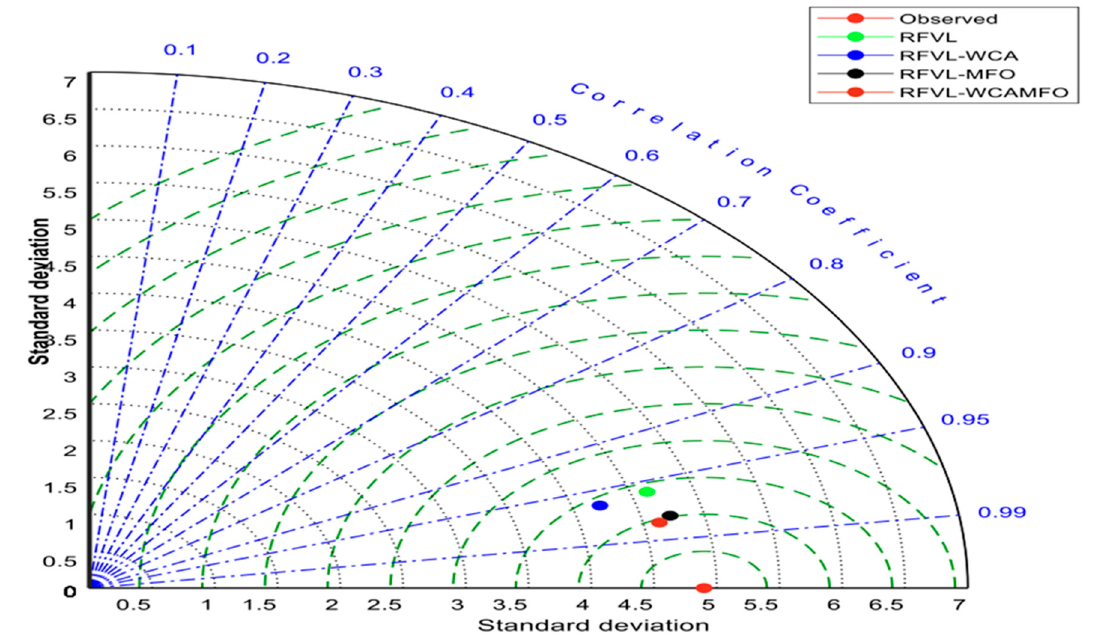
Figure 5. Taylor diagrams of the estimated temperature by different RVFL-based models in the test period for monthly time scale.